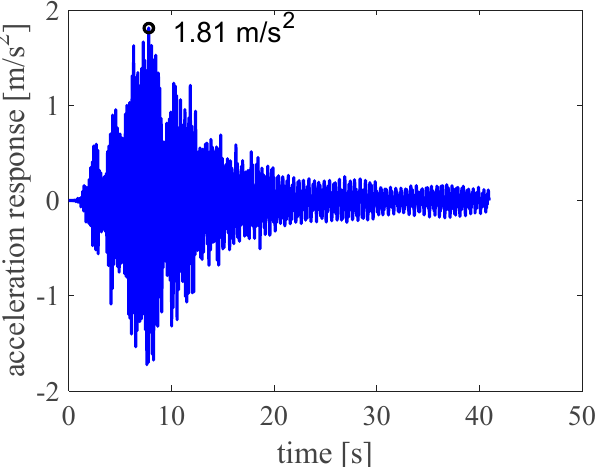
Figure 12. The time history of the structural acceleration responses in the vertical (Z) direction subjected to the Kobe Earthquake (intensity 7), which occurs at time instant t eq = 0 s. Figure 13 shows the empirical cumulative distribution function (CDF) based on the 59 maximum acceleration amplitudes induced by different ground accelerations which are assumed to occur at time instant t eq = 0 s. As shown in Figure 13, most amplitudes ranged from 0.39 to 3.07 m/s 2 .